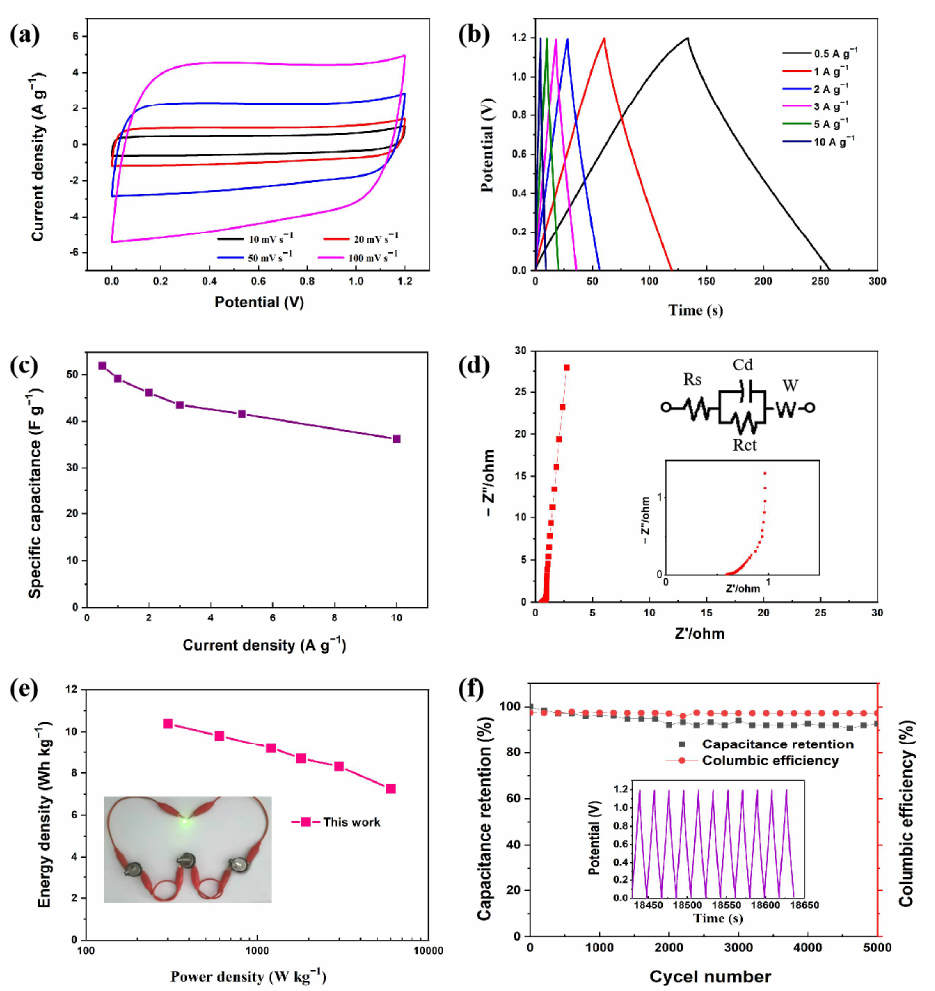
Figure 7. ( a ) CV curves at various scan rates (10–200 mV s − 1 ), ( b ) GCD curves at various current densities (0.5–10 A g − 1 ), ( c ) specific capacitance curves for different current densities, ( d ) Nyquist plot, ( e ) Ragone plot, and ( f ) cycle stability of the symmetric supercapacitor fabricated by two TC-1